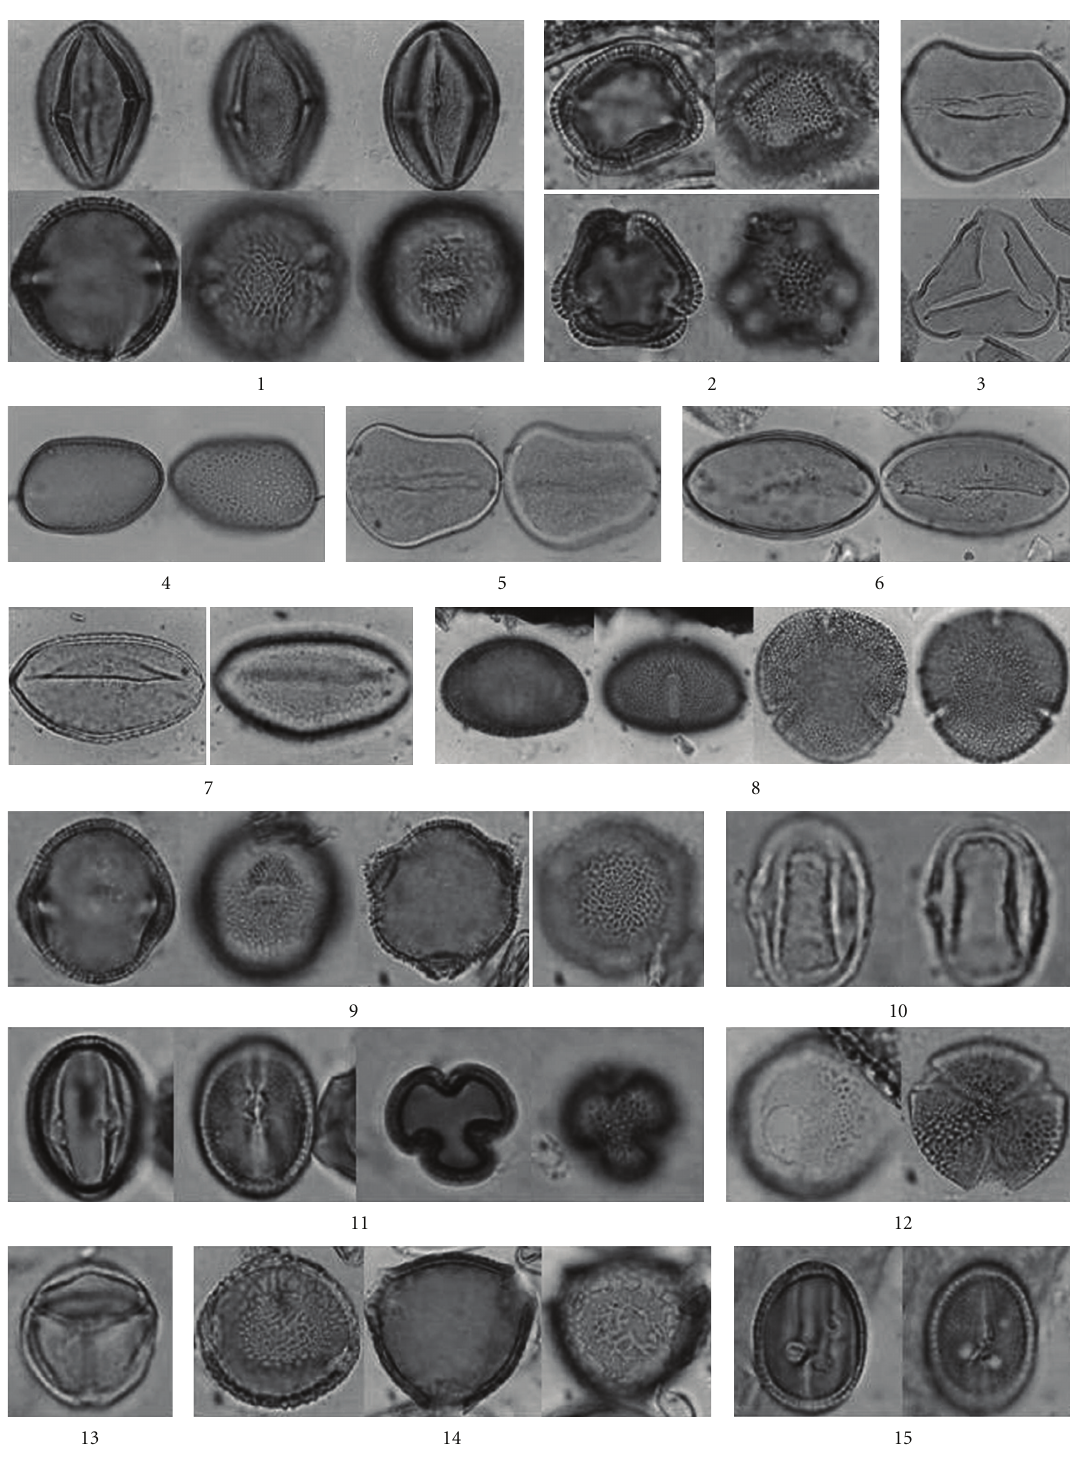
Figure 3: Representative common pollen species taken from nest scutellum. Anacardiaceae: Spondias mombin (1); Araliaceae: Didymopanax morototoni (2); Arecaceae: Cocos nucifera (3); Crysophilla warcewiczii (4); Elaeis oleifera (5); Phytelephas (6); Attalea butyracea (7); Bombacaceae: Pseudobombax septenatum (8); Burseraceae: Bursera simarouba (9); Cecropiaceae: Cecropia peltata (10); Euphorbiaceae: Chamaesyce (11); Dilleniaceae: Davilla nitida (12); Mimosoideae: Mimosa pudica (13); Papilionoideae: Erythrina fusca (14); Machaerium (15). Images not to scale, photographs ×